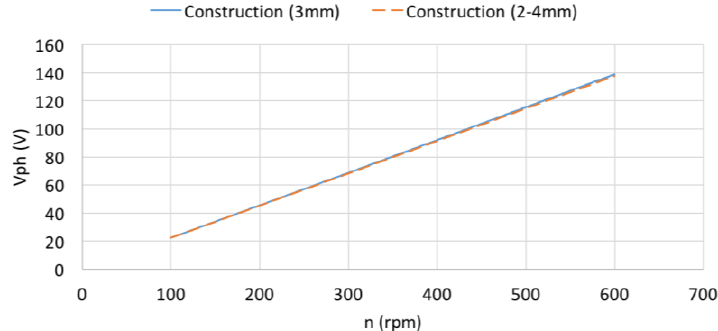
Figure 18. Plot versus the speed of the output phase voltage at no-load in the constructed model with 3 mm air gaps compared to that of the constructed model with 2–4 mm air gaps. 3 mm air gaps compared to that of the constructed model with 2–4 mm air